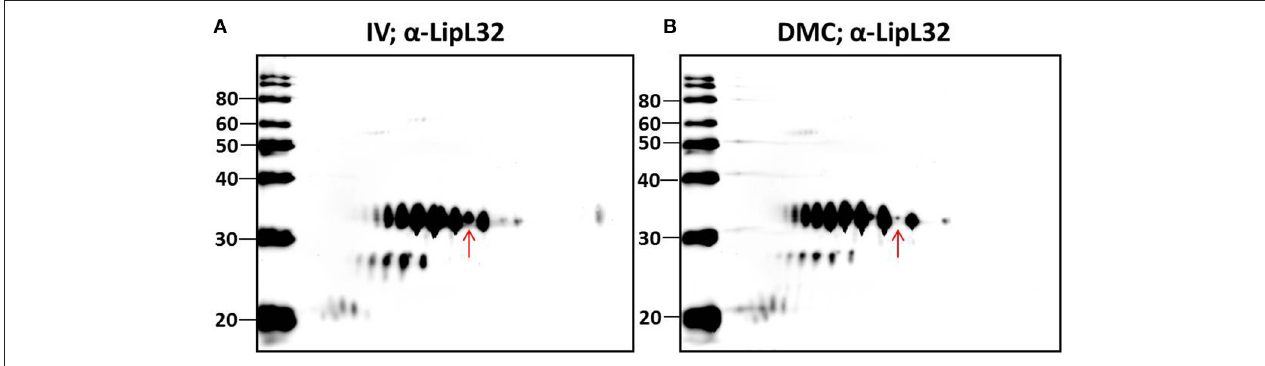
FIGURE 3 | 2-D Immunoblot analysis of (A) IV- and (B) DMC-cultivated leptospires. Approximately 10 7 IV or DMC cultivated leptospires (strain Fiocruz L1-130) were separated by 2-D gel electrophoresis and probed with antiserum specific for LipL32. Red arrow indicates the same protein isoform in each immunoblot of LipL32 when immunoblots are overlaid. Molecular mass markers (kDa) are